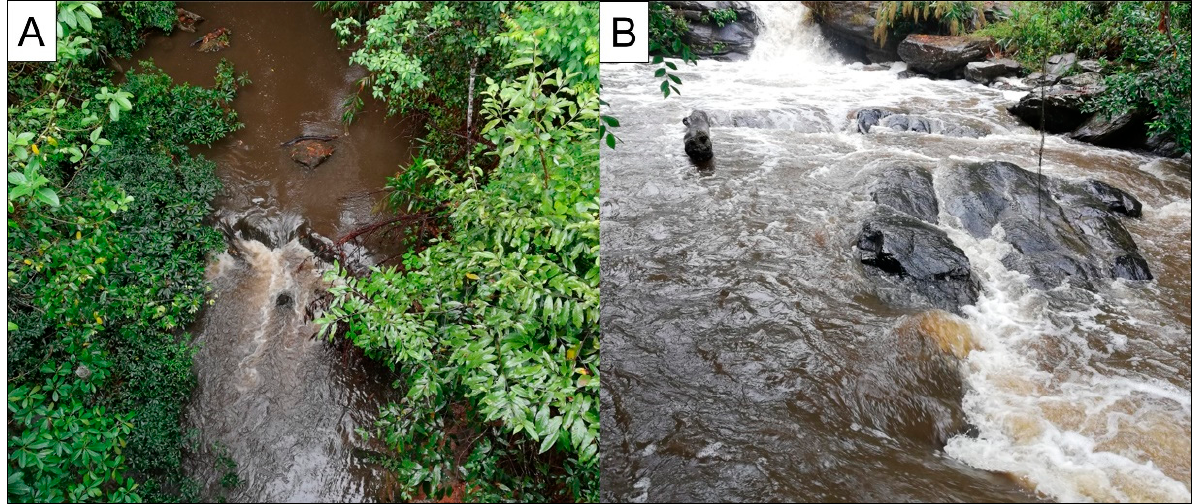
Figure 2. Turbid water at sampling sites. ( A ) KP4 from the Klang Phat River and ( B ) K11 from the Klang River.